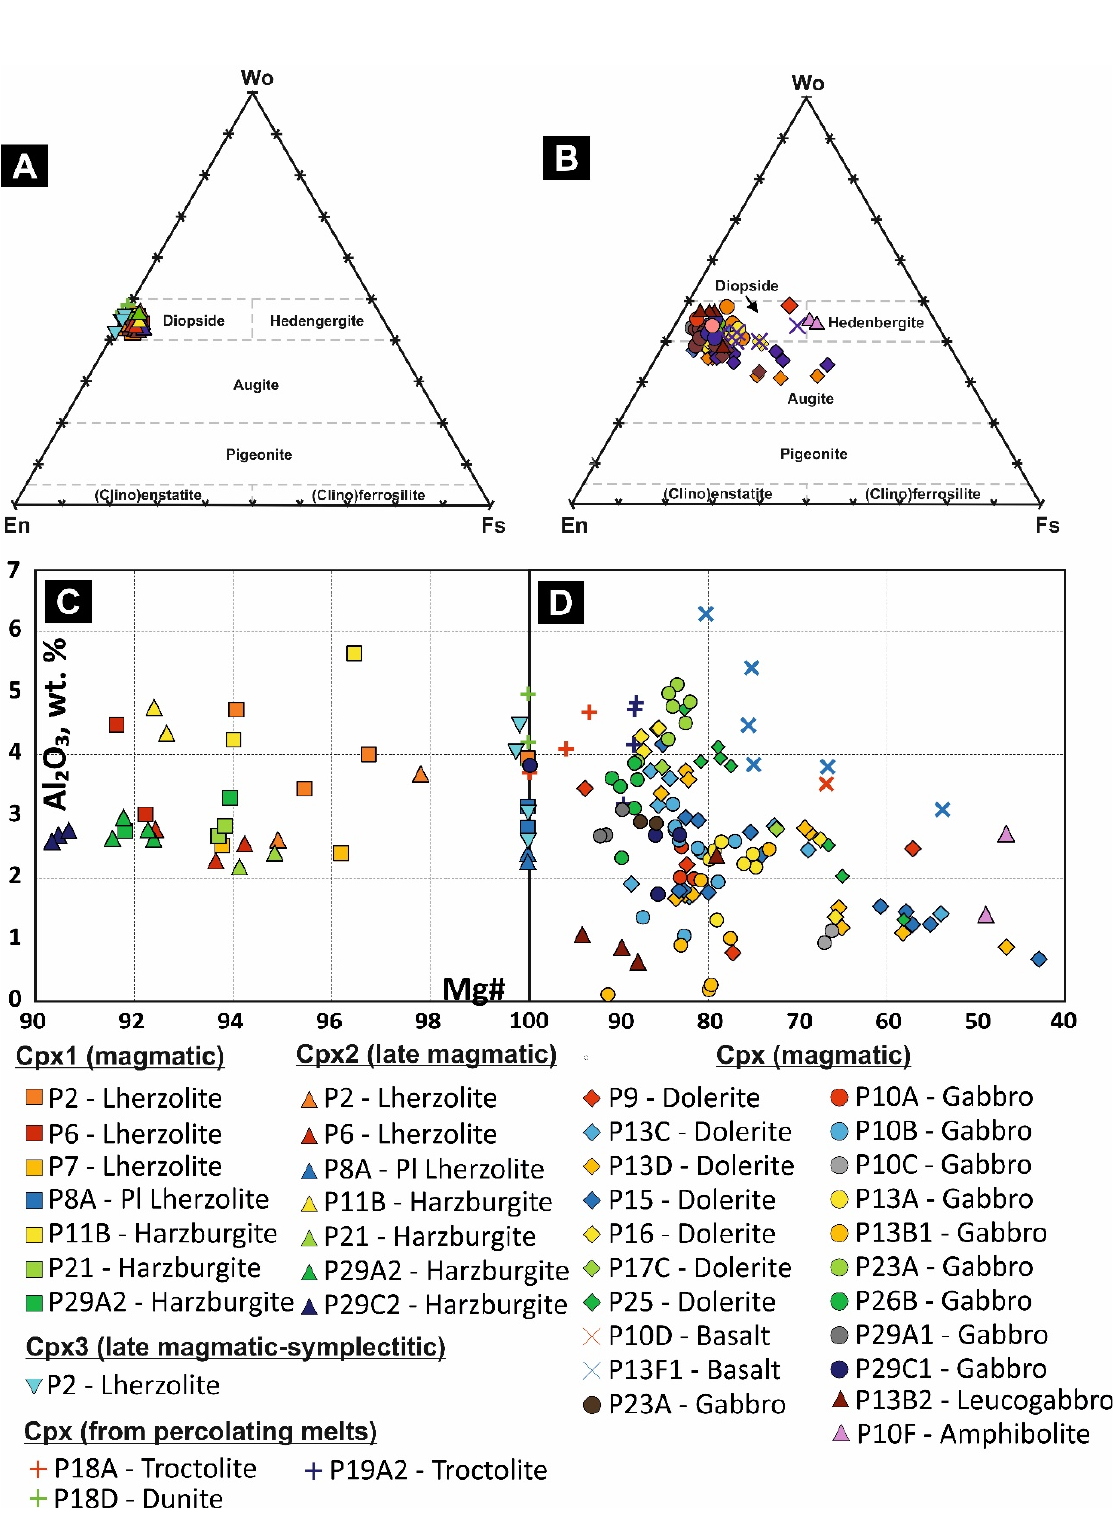
Figure 22. Clinopyroxene classification after [55]. ( A ) Ultramafic rocks. ( B ) Mafic rocks. Relationship between Al 2 O 3 and Mg# = [Mg/(Mg + Fe 2+ ) × 100] atomic ratio in Cpx for ( C ) ultramafic rocks and ( D ) mafic rocks.